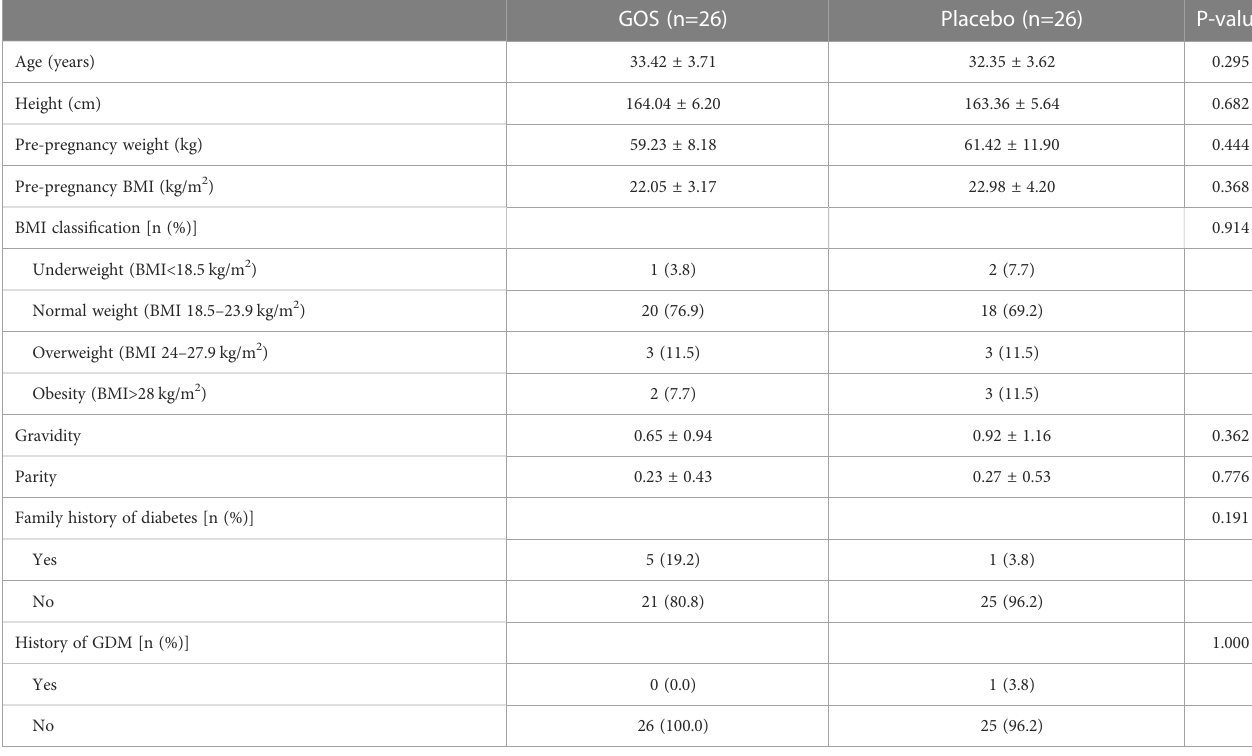
TABLE 1 Baseline characteristics of study participants.